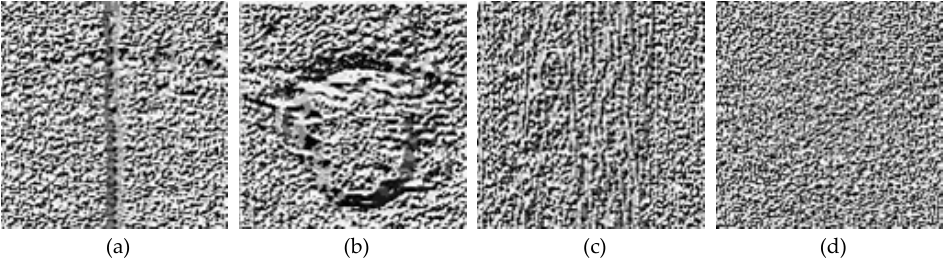
Figure 7. The images after applying LBP feature extraction: scratches ( a ), slags ( b ), peels ( c ), no defects ( d ).